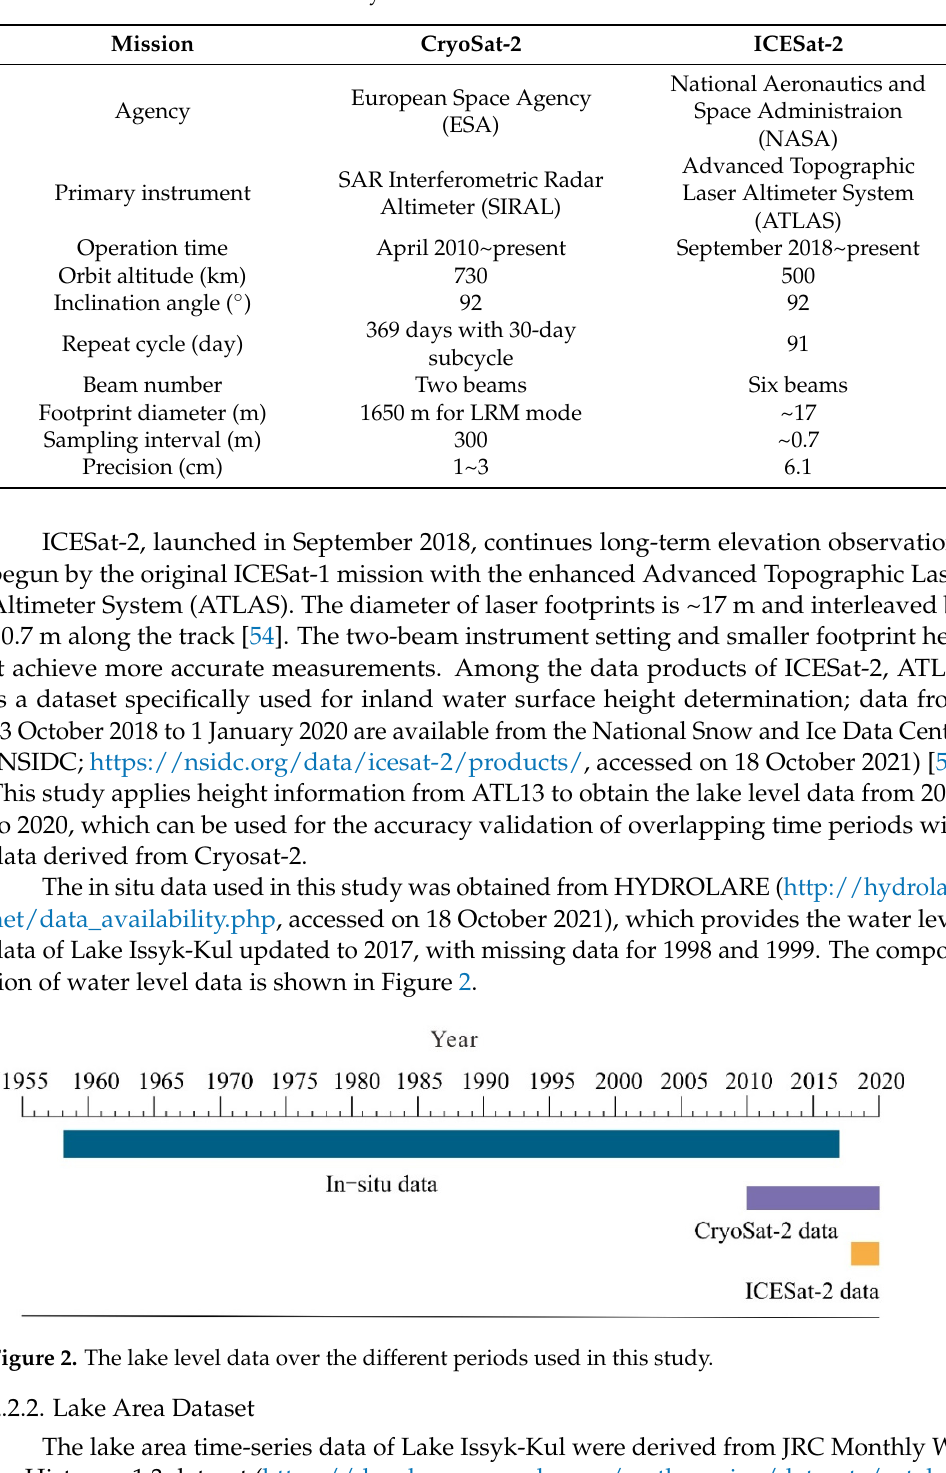
Table 1. The main characteristics of CryoSat-2 and ICESat-2 missions.